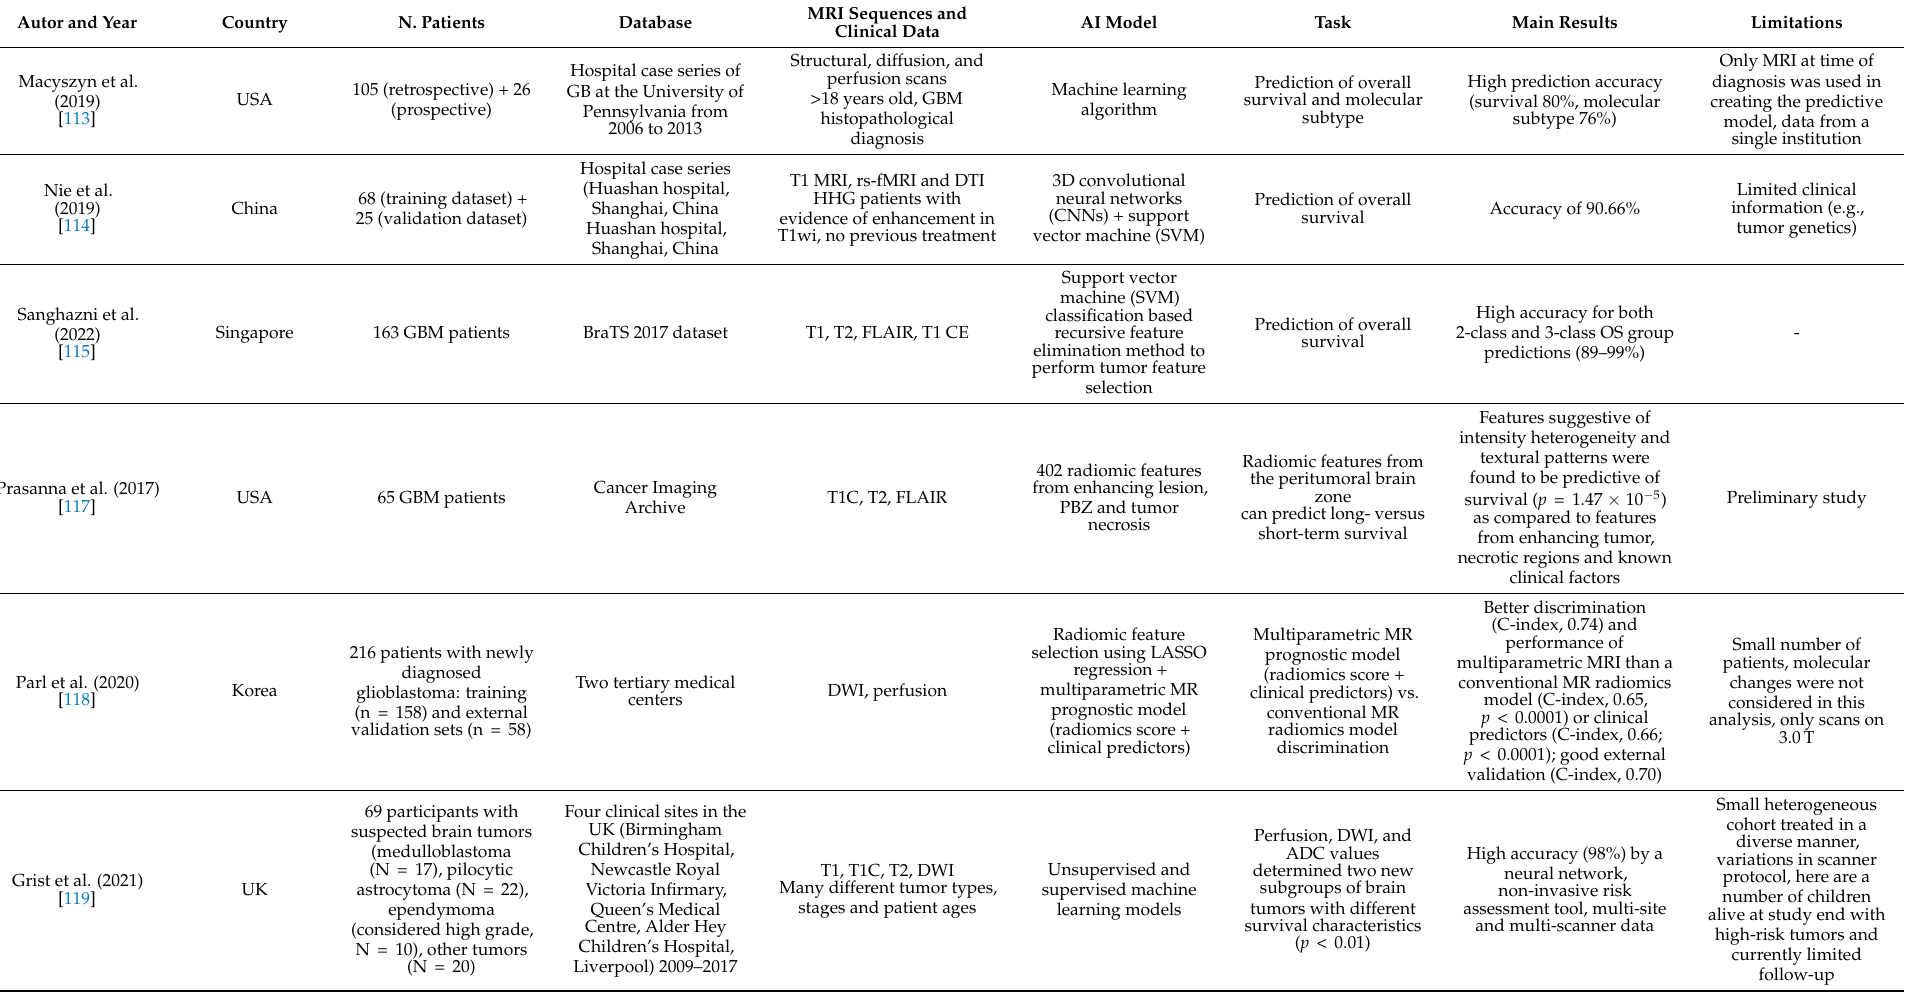
Table 3. Main characteristics and results of studies aimed on